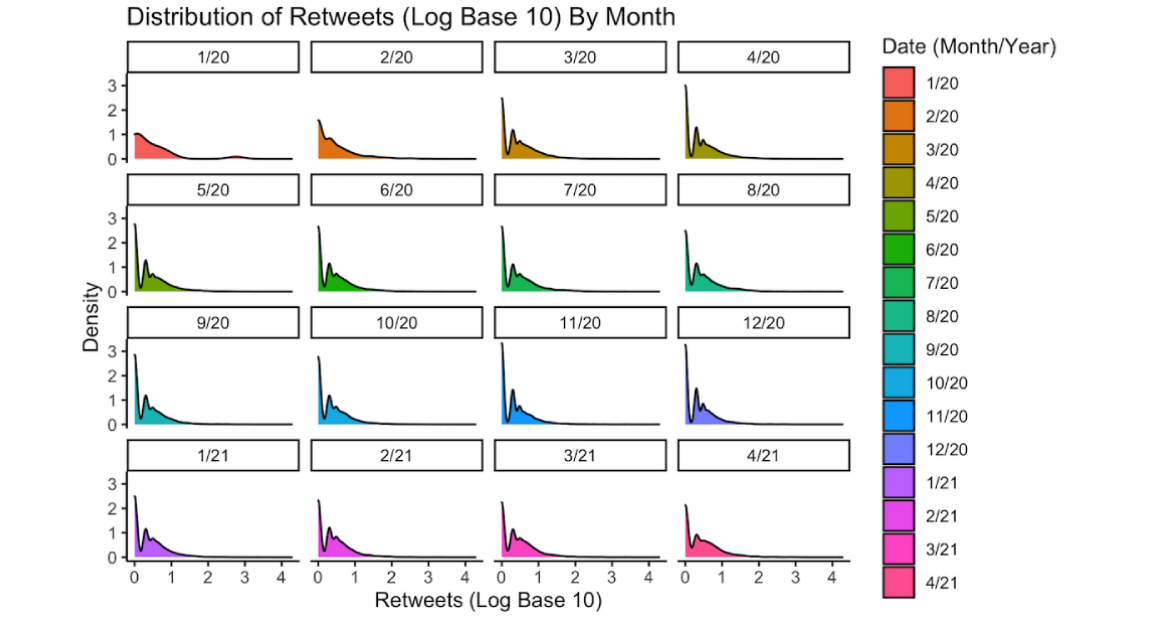
Figure 2. Monthly variations in the base 10 log number of retweets for tweets mentioning COVID-19 and telemedicine. Note that 219,212 tweets (62.2%) had no retweets and are not included in this